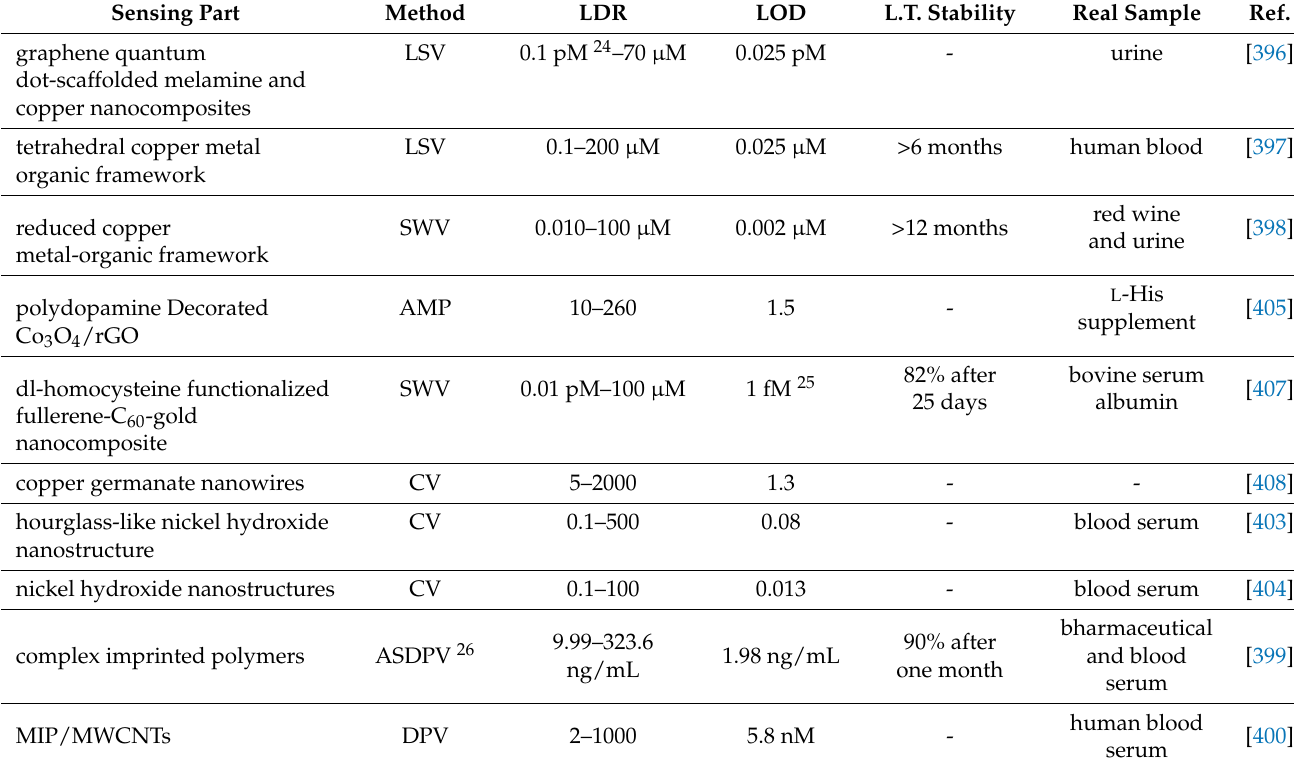
Table 6. Proposed electrochemical histidine sensors, since 2010, along with the most important corresponding figures of merit. LDR LOD L.T. Stability Real Sample